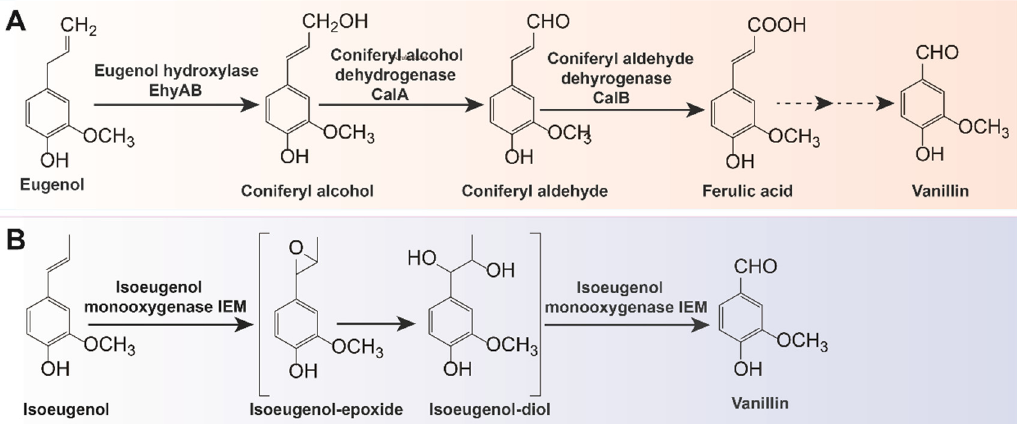
Figure 3. Two biotransformation pathways of vanillin: ( A ) biotransformation pathway from eugenol to vanillin; ( B ) biotransformation pathway from isoeugenol to vanillin.